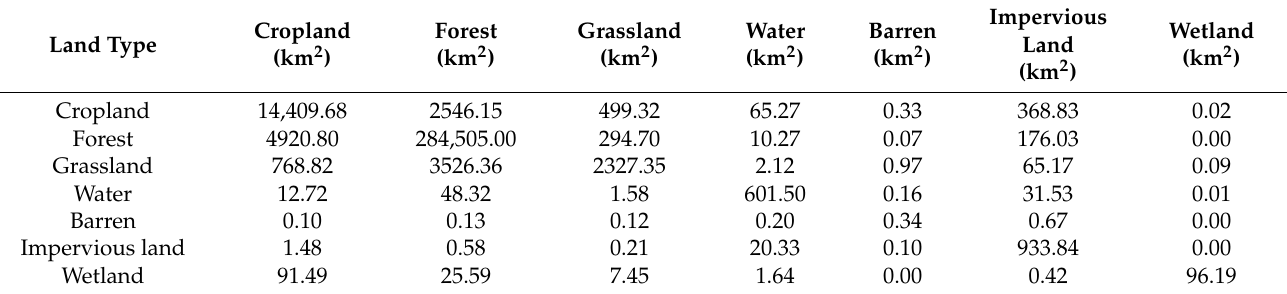
Table 2. Land use change matrix from 2000 to